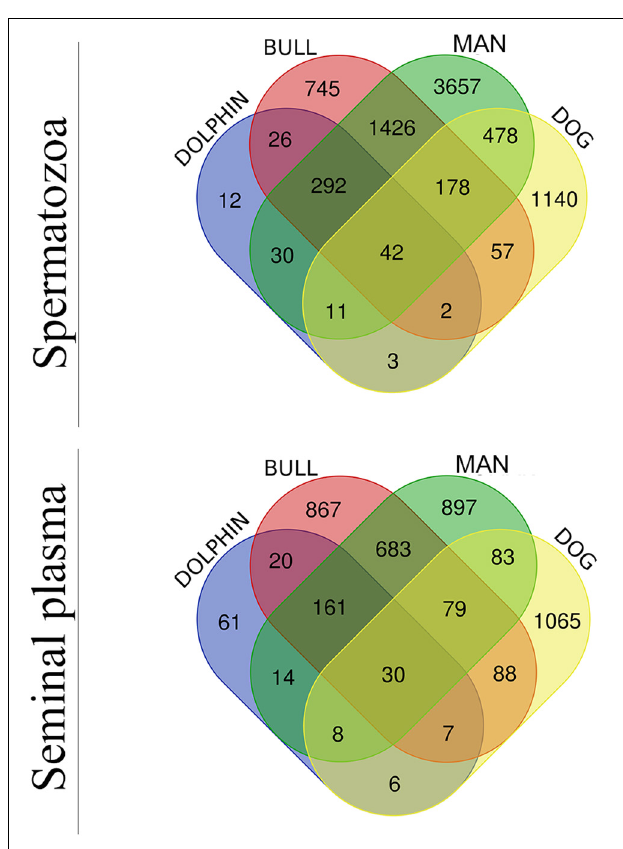
FIGURE 2 | Venn diagram of sperm (upper diagram) and seminal plasma (lower diagram) proteomes of man, bull, dog and